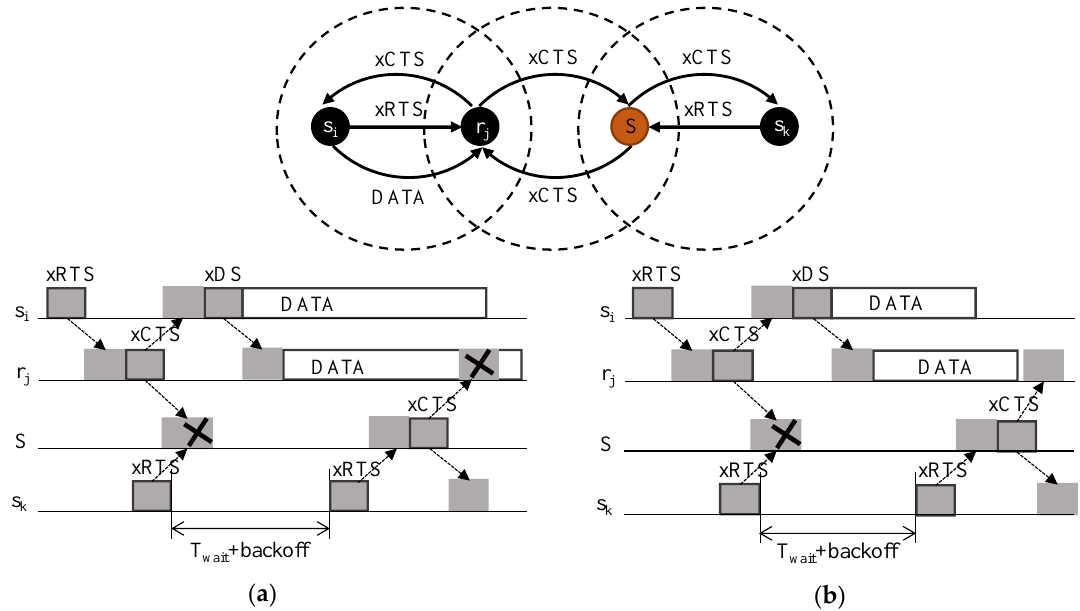
Figure 2. Multi-hop scenario without wake-up tones; ( a ) A long data frame causes CTS collisions; ( b ) A short data frame avoids CTS collisions.